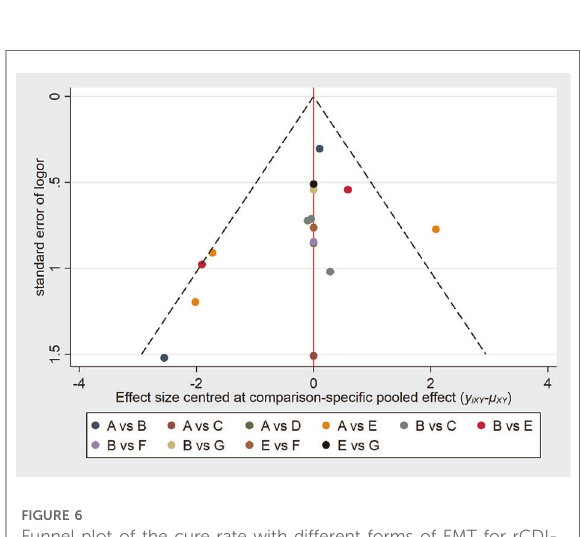
FIGURE 6 Funnel plot of the cure rate with different forms of FMT for rCDI- associated diarrhea. ( A ) fresh fecal bacteria; ( B ) frozen fecal bacteria; ( C ) lyophilized fecal bacteria; ( D ) autologous fecal bacteria; ( E ) vancomycin; ( F ) fi daxomicin; ( G ) rectal